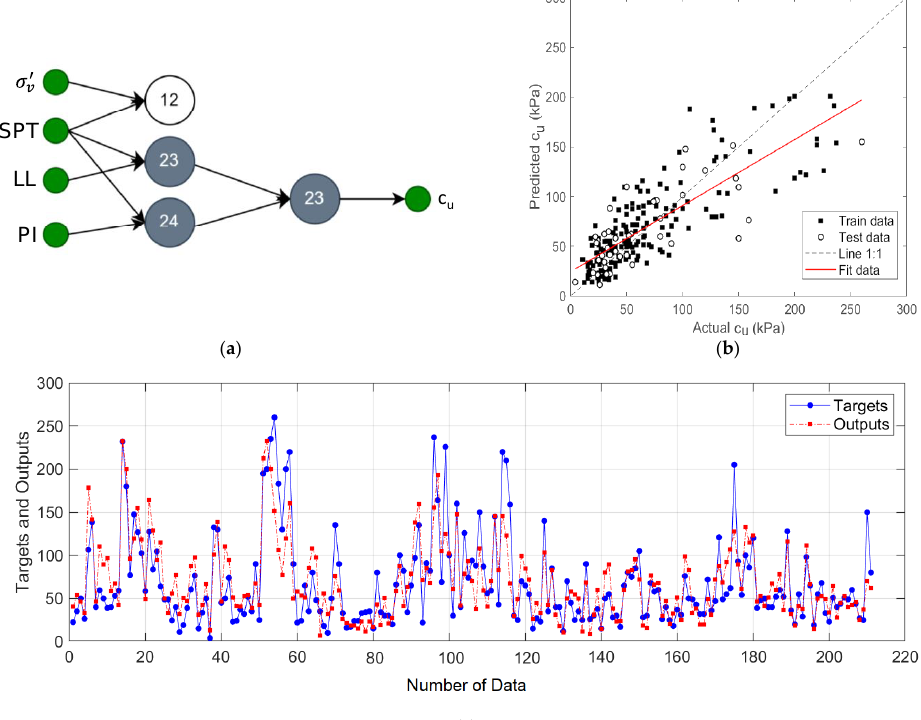
Figure 7. The proposed prediction model for input variables σ v ’ , N SPT , LL , and PL : ( a ) two-layer GMDH-type NN structure; ( b ) regression plot; ( c ) target and output predictive values. The GMDH-type NN structure using all input variables and the performance results of this model are given in Figure 8. In this model, the variable pair { σ v ’ , N SPT } was disabled because it increased the error rate, and the remaining neuron outputs formed pairs and were used in the next layer. The results given in Figure 8b,c show that the GMDH-type NN model achieved R 2 of 0.83, MAE of 14.64, and RMSE of 22.74 values.